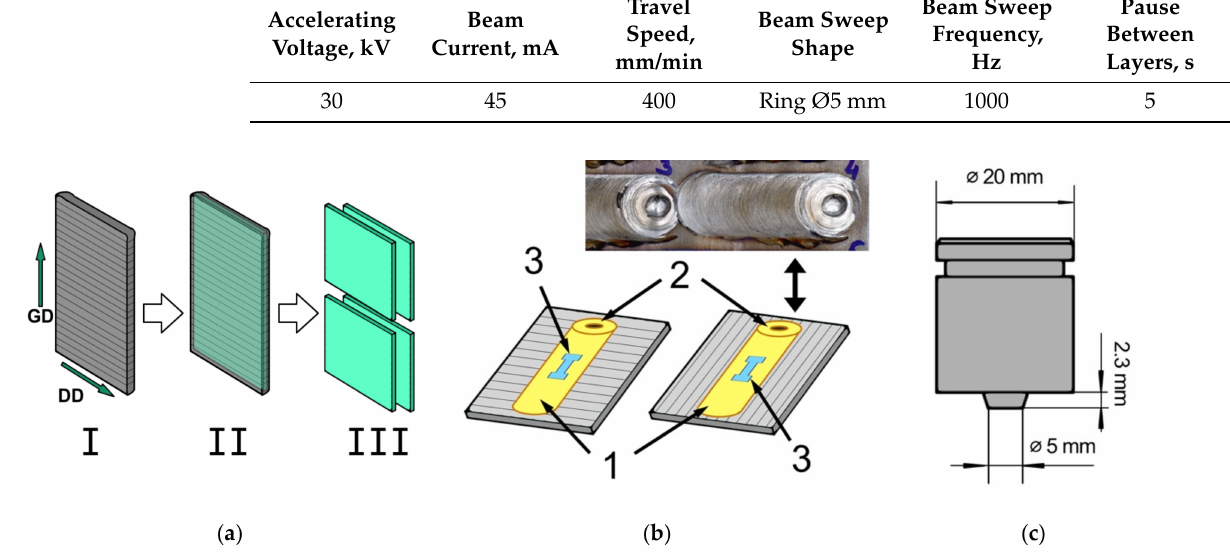
Figure 2. Schemes of samples cutting ( a , b ) and FSW-tool ( c ): ( a ) Production of FSP workpieces; ( b ) Cutting test coupons from FSP area. I, II, II—the stages of obtaining workpieces; 1—stir zone, 2—tool outlet area; 3—test